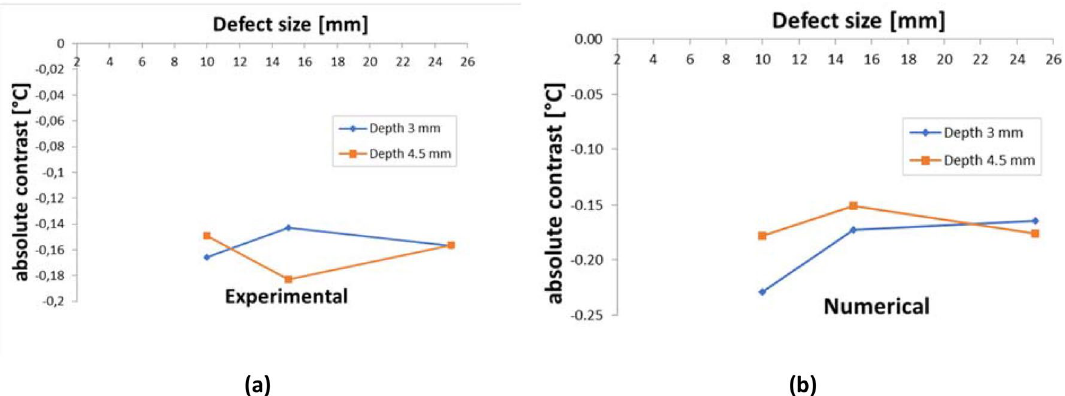
Fig. 18 Absolute contrasts vs defect size for experimental ( a ) and numerical ( b ) SMArt